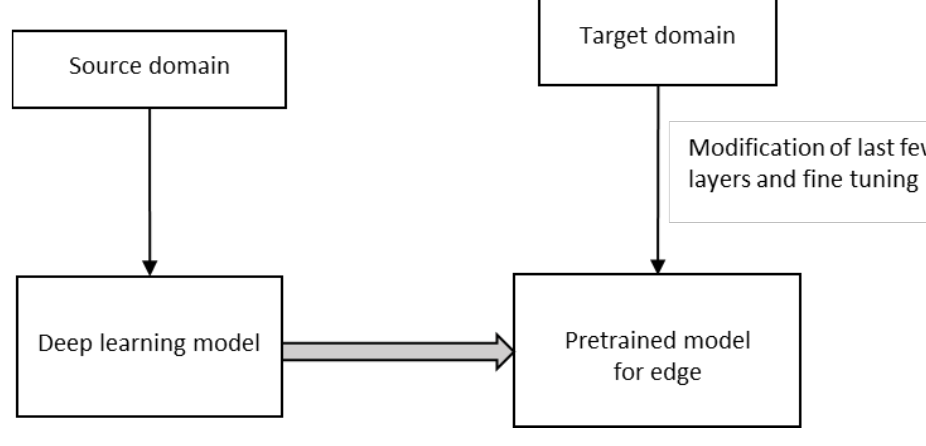
Figure 9. Deep transfer